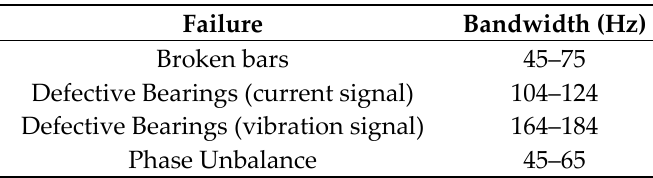
Figure 12. Detected components related to different combinations of failures through MUSIC, as to the signal of current and vibration, as shown in [25]. Reproduced with permission from IEEE, 2017. Table 14. Bandwidth associated with